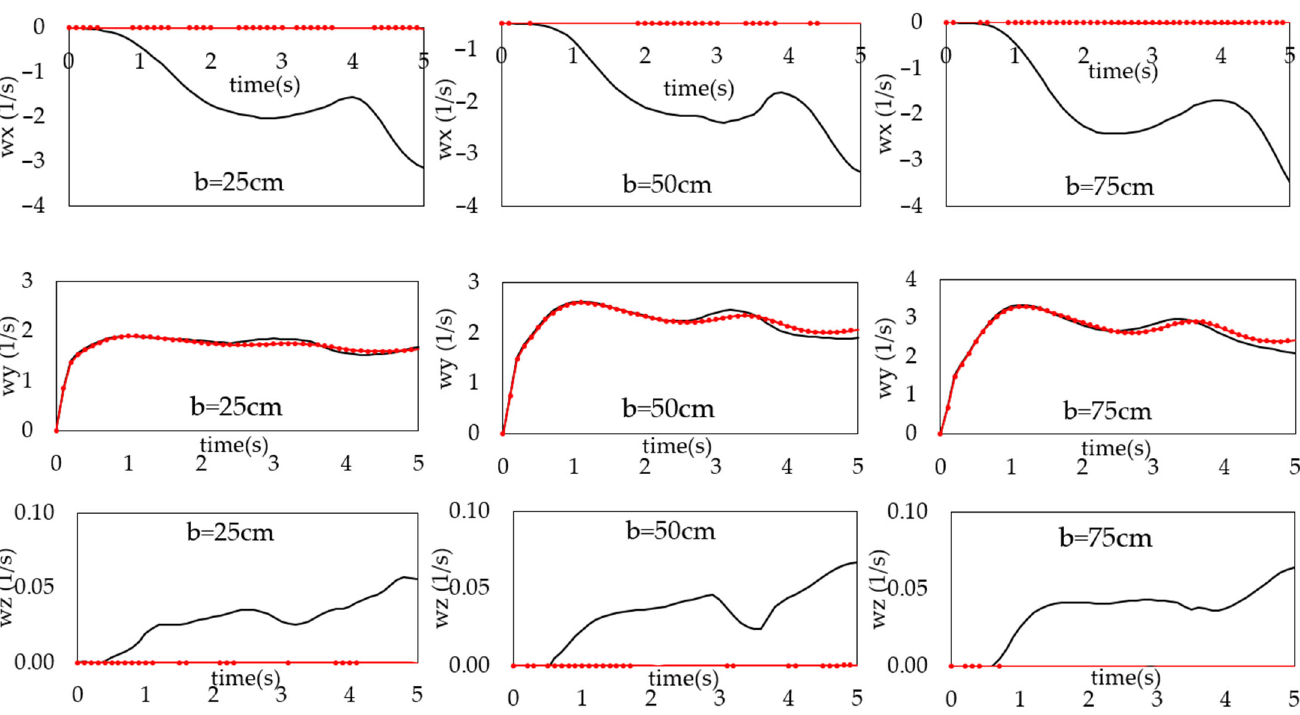
Figure 11. Near − bed vorticity components at the center of dam site. Black solid line: cases 7A, 8A, 9A; red dotted line: cases 7B, 8B, 9B.